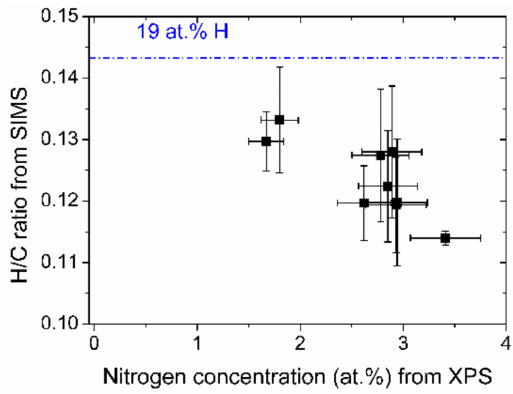
Figure 6. Relative hydrogen content vs. nitrogen concentration of the (N-)DLC samples. The value of the hydrogen / carbon ratio of a sample containing 19 at % hydrogen is indicated by a